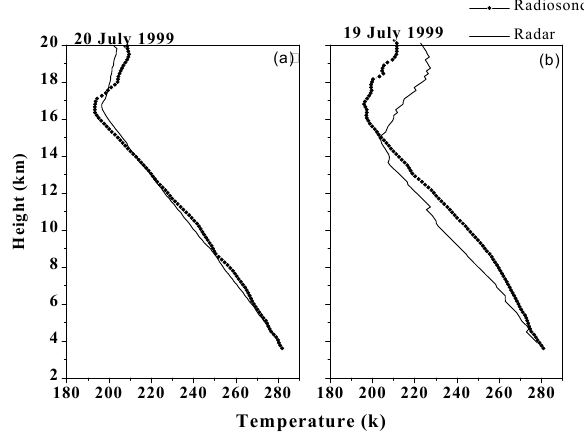
Fig. 3. Comparison of radar derived temperature profiles with ra- diosonde measured temperatures profiles (a) on a clear day (20 July 1999) and (b) on a cloudy day (19 July